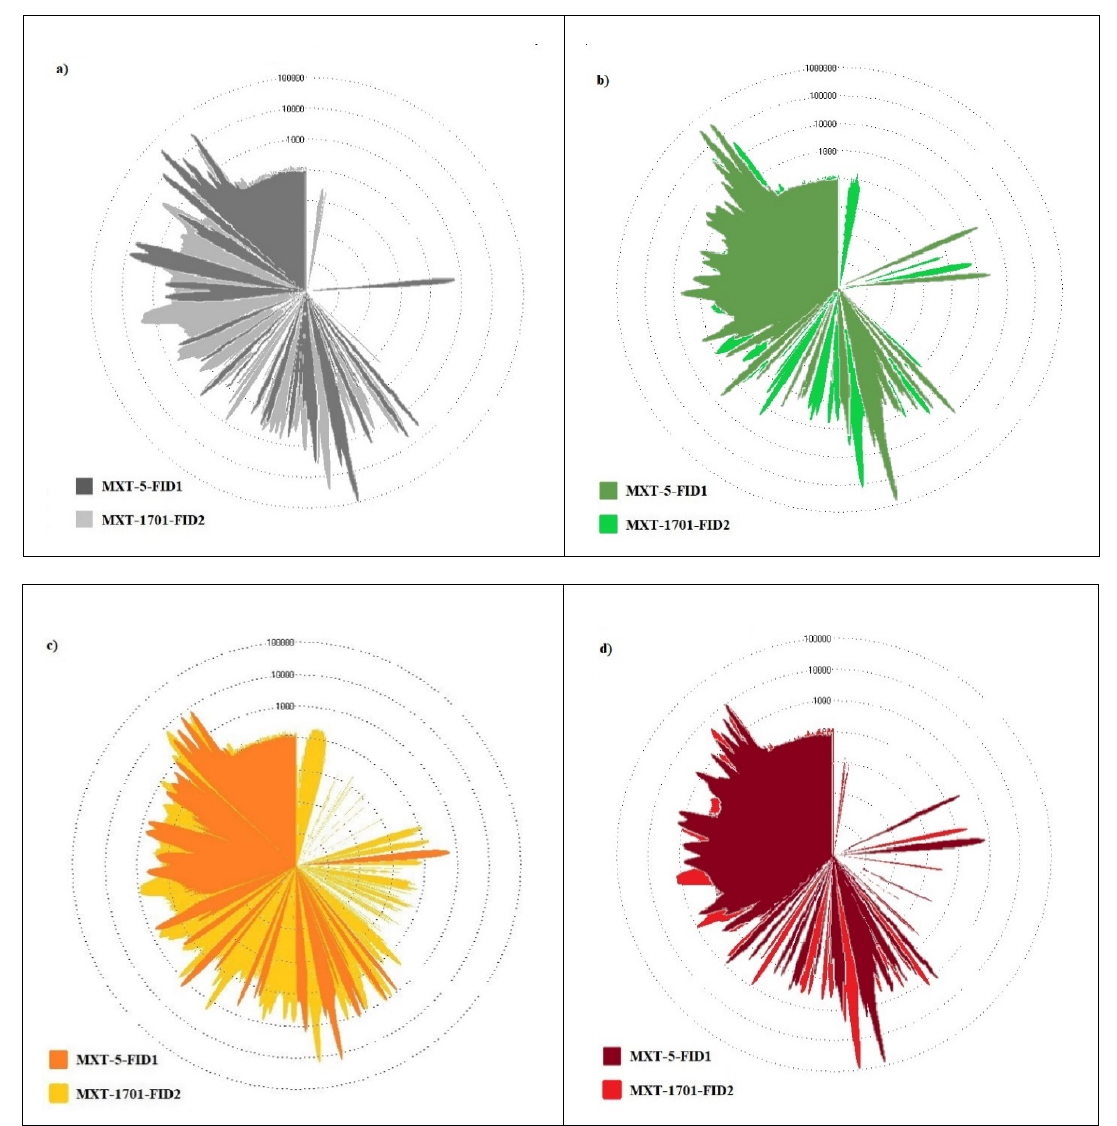
Figure 3. Radar plots (odor maps or fingerprints), obtained by using an electronic nose with MXT-5 column and MXT-1701 column, of red Topepo fruits cultivated ( a ) without fertilizers (CTR); ( b ) with vegetable compost (CV); ( c ) with olive compost (CO); ( d ) with horse dung (HD).